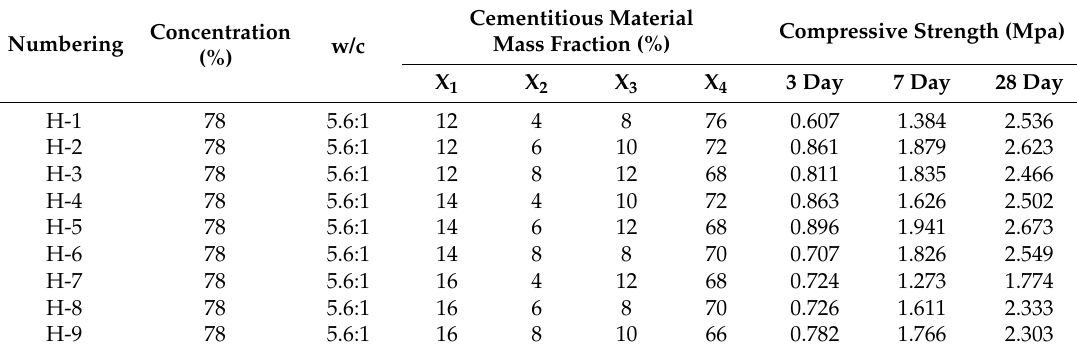
Table 3. Orthogonal test table and uniaxial compressive strength (UCS) results.